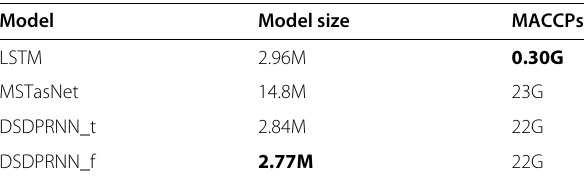
of our proposed methods and several typical DNN-based RES methods Model